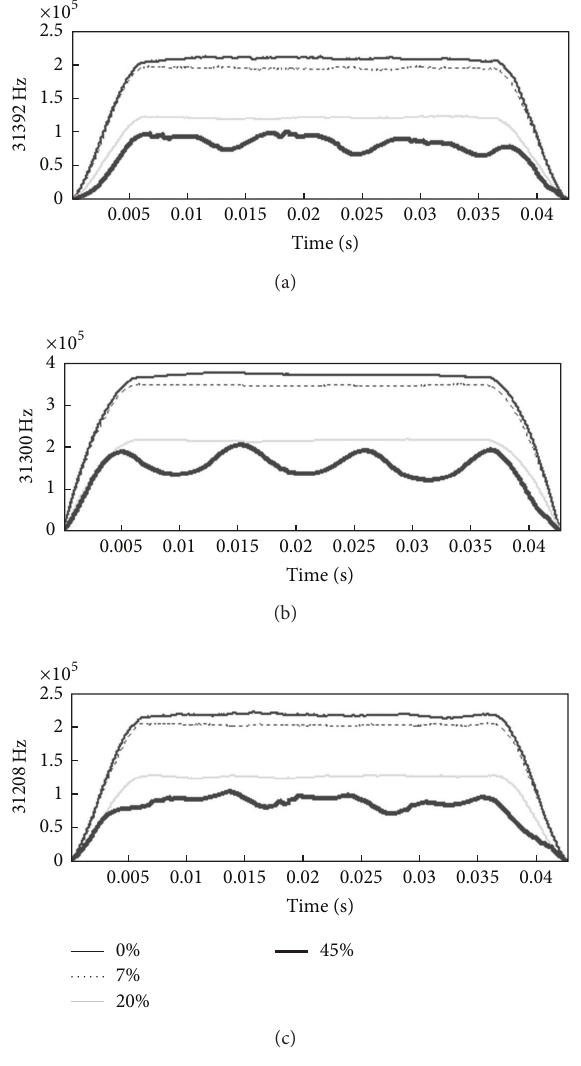
Figure 4: The amplitude fluctuation of the ZAM transform at the corresponding VAM frequencies, that is, 31392 Hz (a), 31300 Hz (b), and 31208 Hz (c) for each crack size (0%, 7%, 20%, and 45%), respectively.